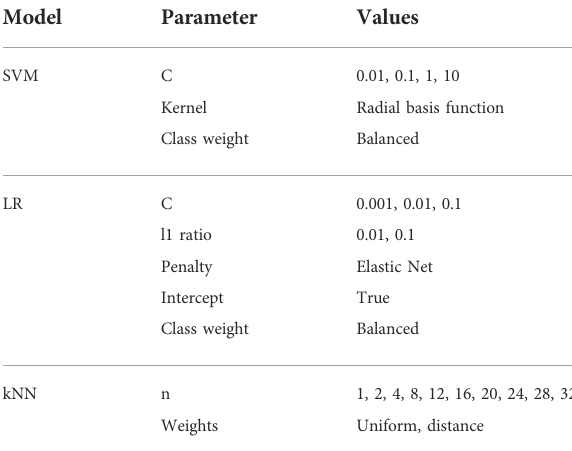
TABLE 3 Descriptive activity